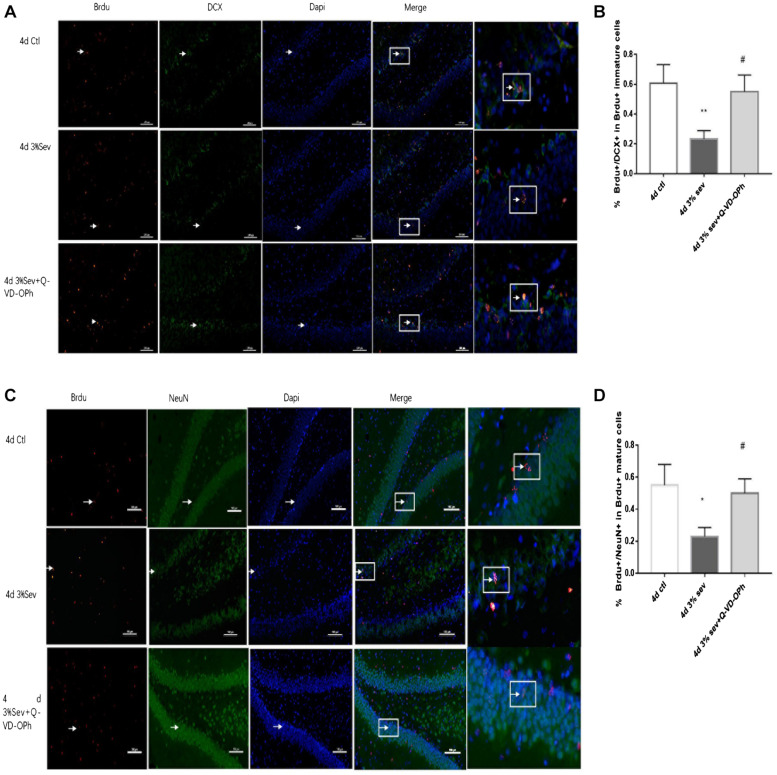
(A) Caspase-3 inhibitor alleviated sevoflurane-induced decrease of differentiation into DCX in BrdU+ immature cells 4 days after anesthesia. (C) Caspase-3 inhibitor alleviated sevoflurane-induced decrease of differentiation into NeuN in BrdU+ mature cells 4 days after anesthesia. Scale bar = 100 μm. (B) Quantification percentage of BrdU+/DCX+ in BrdU+ immature cells. (D) Quantification percentage of BrdU+/NeuN+ in BrdU+ mature cells. Values are presented as mean ± SD, n = 3; *P < 0.05 compared with the control 4 days group, **P < 0.01 compared with the control 4 days group, #P < 0.05 compared with the 4 days sevoflurane group. One-way ANOVA with Newman–Keuls post hoc test or Kruskal–Wallis with Dunn’s Multiple comparison test was used for data analysis.